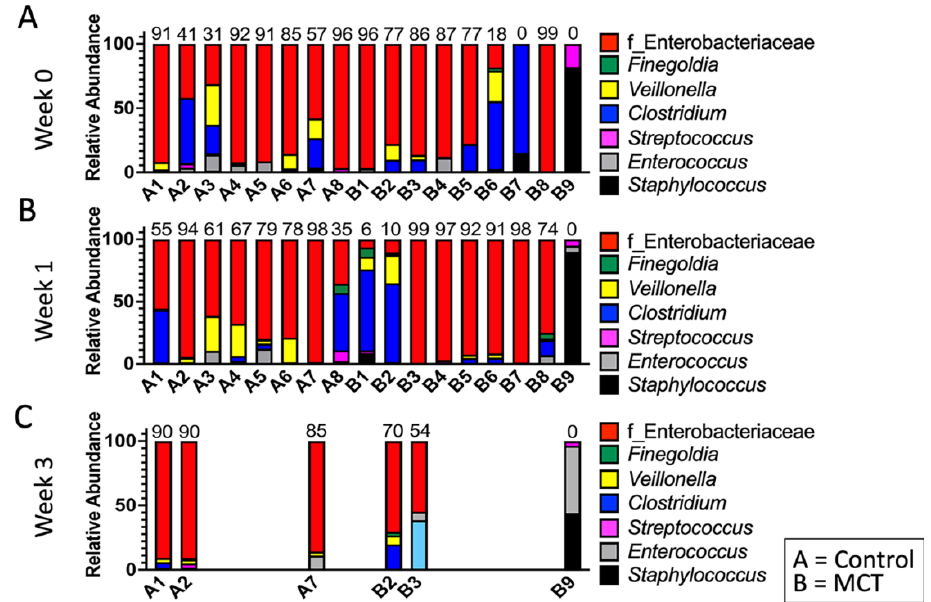
Figure 3. Infant gut microbiota is dominated by Enterobacteriaceae and is not impacted by MCT supplementation. Top bacterial taxa observed in stool bacterial communities are displayed over three weeks. ( A ) Week 0 indicates samples collected before supplementation began. ( B ) Week 1 indicates samples collected after one week of MCT supplementation. ( C ) Week 3 indicates samples collected after three weeks of MCT supplementation. Infants A1–A8 belong to the control group. Infants B1–B9 belong to the group that received MCT. Only six infants remained in the study by week 3. Numbers above bars represent the percentage of Enterobacteriaceae in a particular infant.